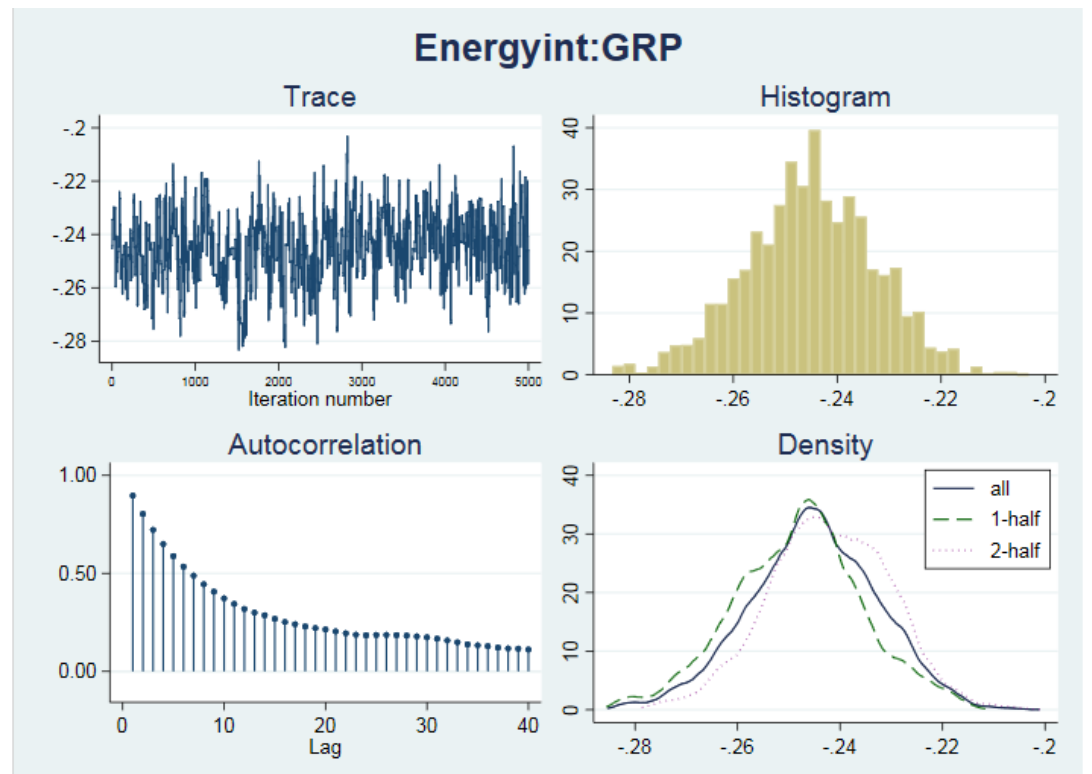
Figure 4. Multiple posterior density simulated by MCMC for logarithm of per capita income variable